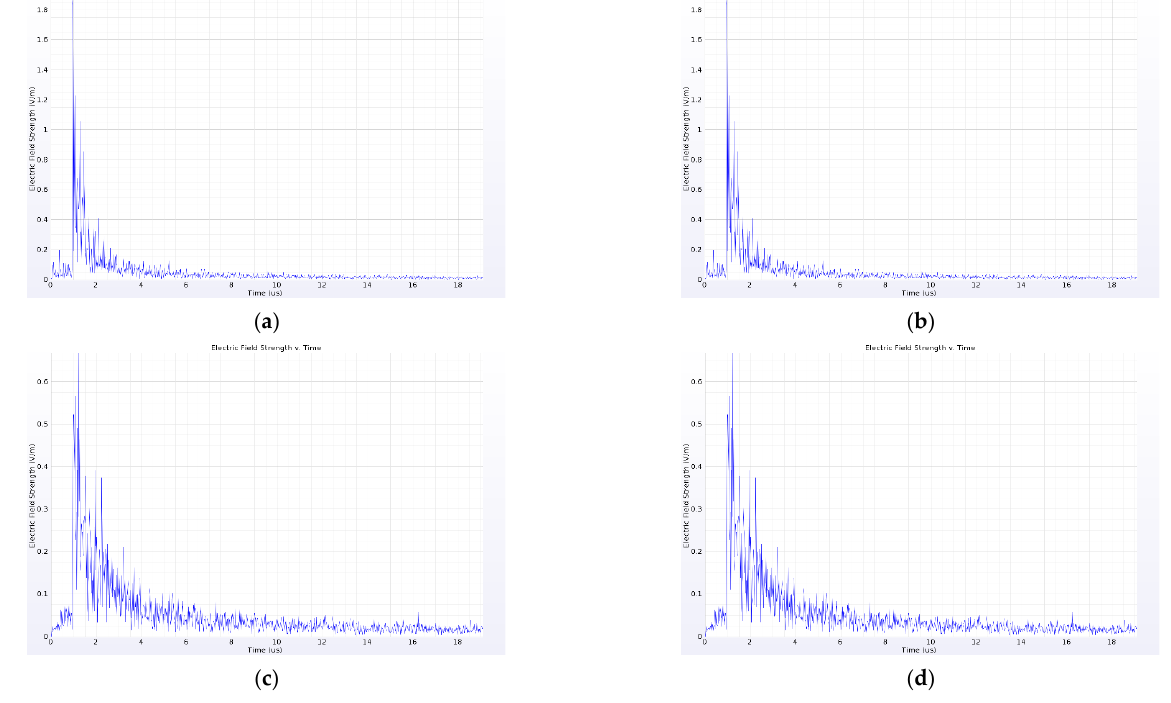
Figure 12. Effect of busbar on near-field propagation characteristics of PD electromagnetic wave signal. ( a ) Electric field strength at point sensor 1; ( b ) Electric field strength at point sensor 2; ( c ) Electric field strength at point sensor 3; ( d ) Electric field strength at point sensor 4.